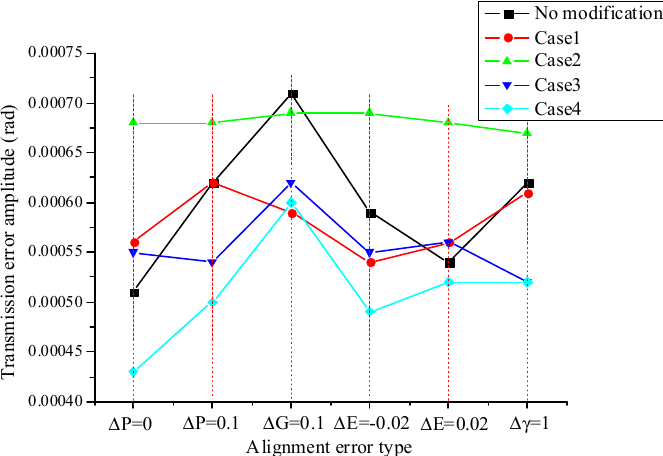
Figure 22. Variation of transmission error amplitudes of driving pinion under different modification in different installment conditions.